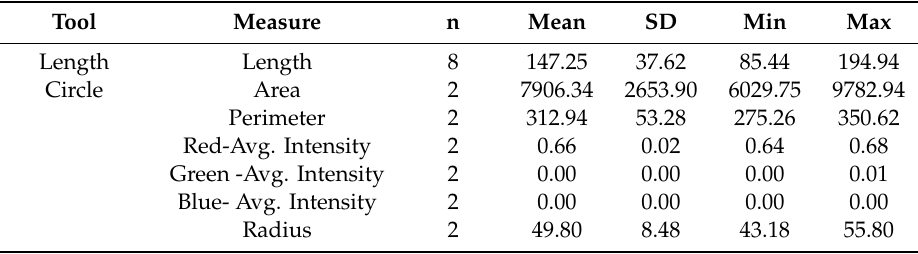
Figure 17. ( a ) SEM micrograph at 200 µm, ( b ) Assessment of fibers at 90 0 by image segments analysis. Table 8. Digimizer statistics of fiber 90° orientation in image segmentation analysis.